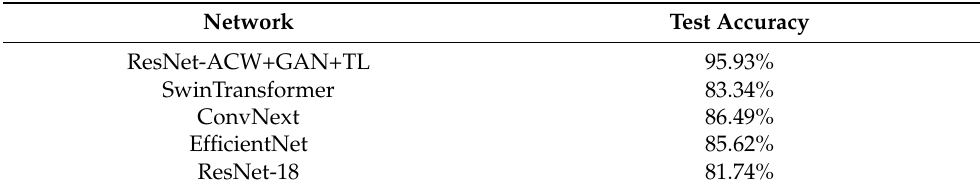
Figure 16. Train losses of the networks. Table 12. Test results of different networks and our